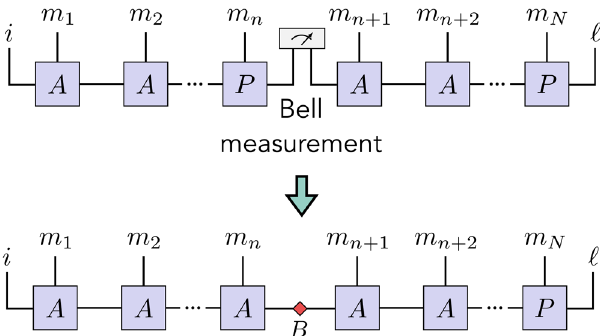
FIG. 3. The fusion of two AKLT states via Bell measurement. After preparation, the edge spin-1/2s of each MPS are each entangled with a memory qubit. Through entanglement swap- ping, Bell measurement of memory qubits belonging to different chains “fuses” the two independent MPSs, teleporting a partic- ular tensor M = { I , X , Y , Z } to the intermediate bond. Using the fact that A m = P m S and S ∝ Y , this amounts to a longer AKLT state with the local Pauli defect B ∝ YM .